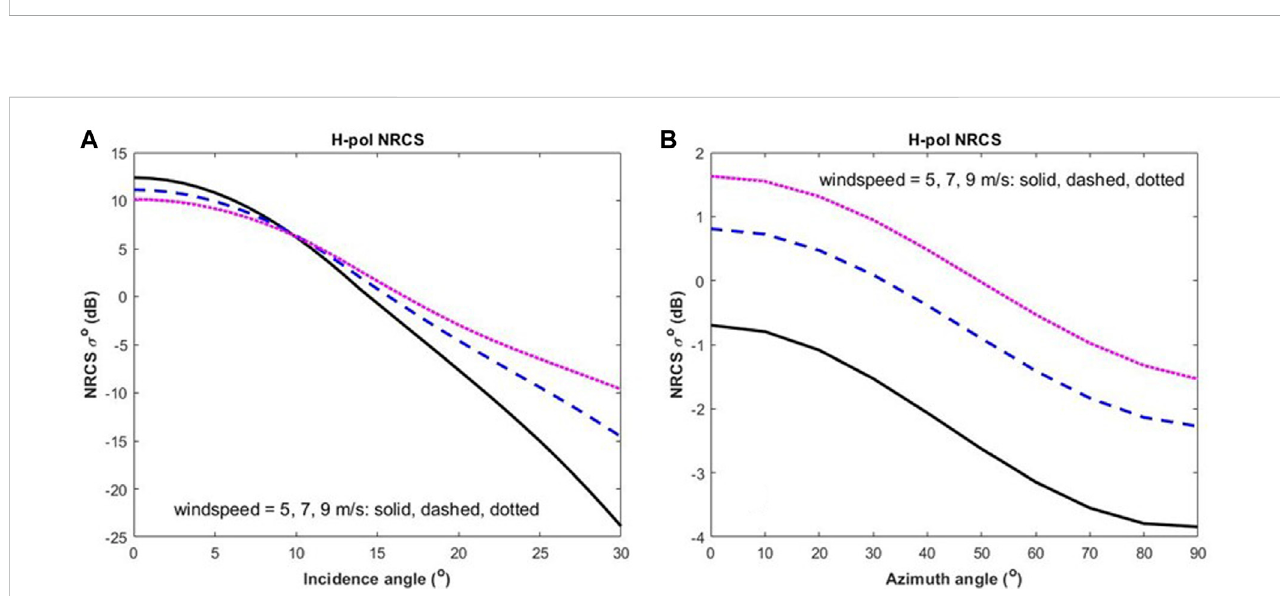
FIGURE 4 Similar to Figure 3,except for NRCSvariationsat70 GHzchannelwith (A) incidence angleand (B) azimuth angle of winddirectionat15 ° incidence angle. The windspeeds in the simulation are 5 m/s (black solid curve), 7 m/s (blue dashed curve), and 9 m/s (magenta dotted